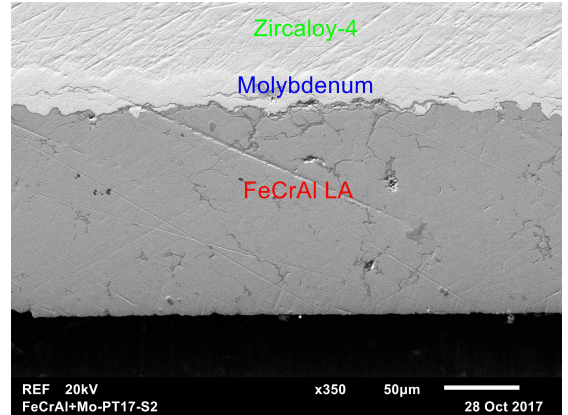
Figure 19. SEM micrograph of the PT17 sample after the test (all three runs). The cracks in both FeCrAl and Mo coating are visible. There is no spallation visible but the bonding between FeCrAl and Mo was